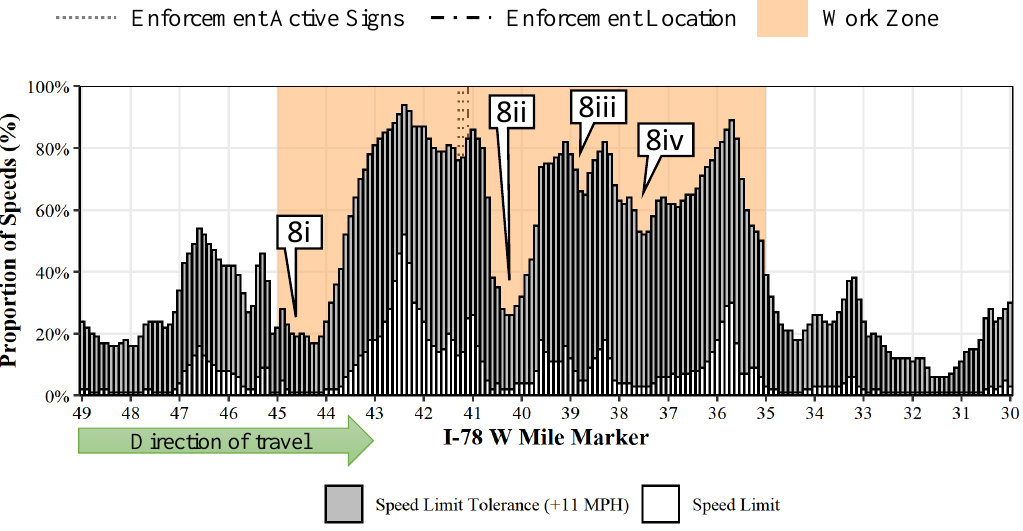
Figure 8. Compliance with speed limit and within speed limit tolerance on 10 mi I-78 W work zone. Callouts 8i-8iv highlights the speed fluctuations.